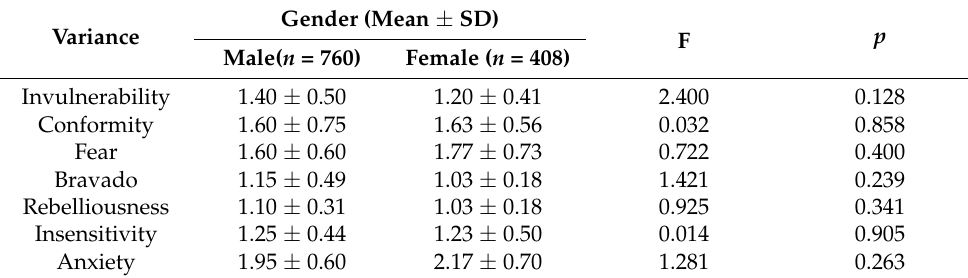
Table 7. The difference in psychological symptoms across the genders. Variance